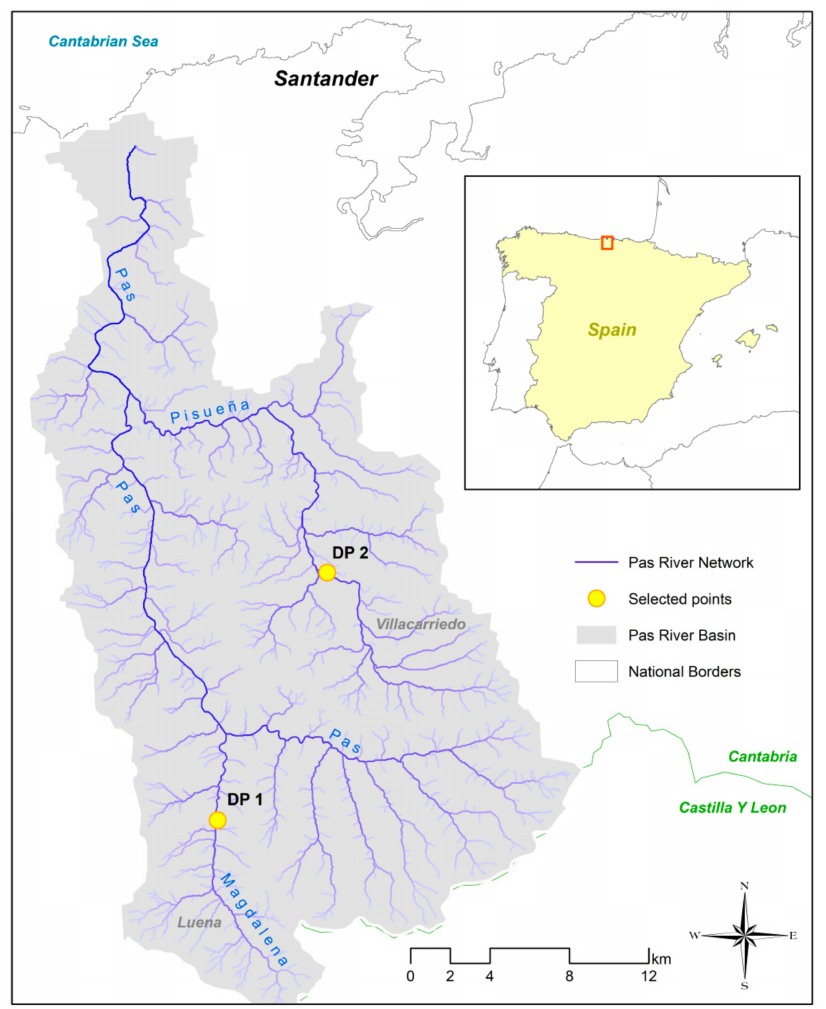
Figure 3. Location of the Pas River basin and the river sections in proximity to the selected diversion points (indicated as “DP”). For illustration purposes we added shading to the river network, linked to average river